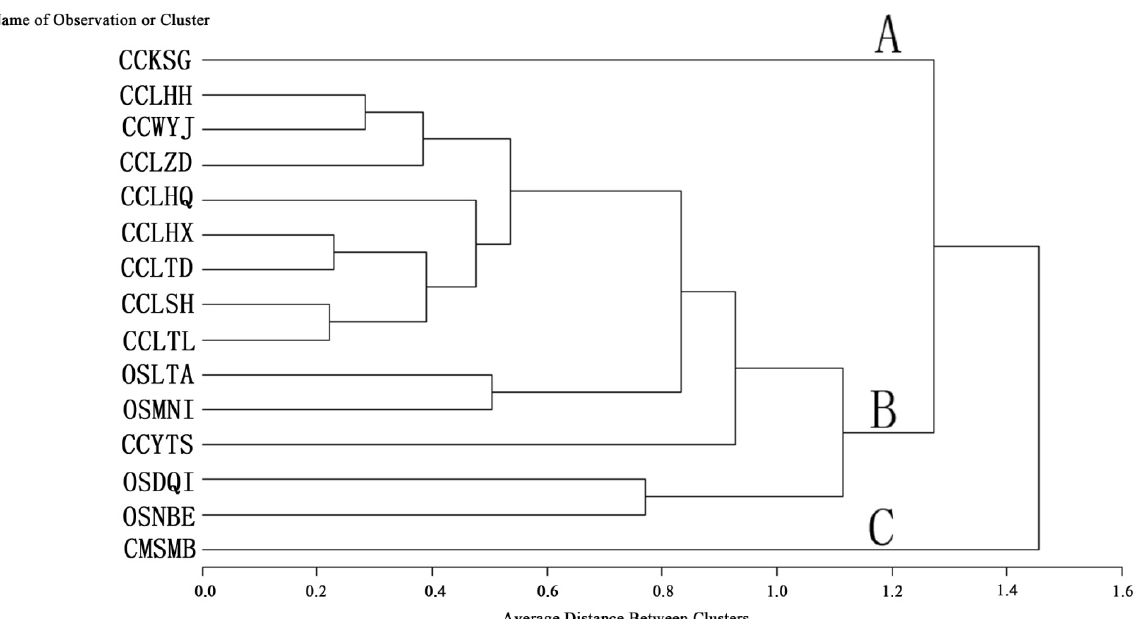
Figure 3. Q-Cluster of 10 nucleosides assayed in coremium (stroma) of 10 populations of C. cicadae , four populations of O. sinensis , and one population of C. militaris , using the average linkage